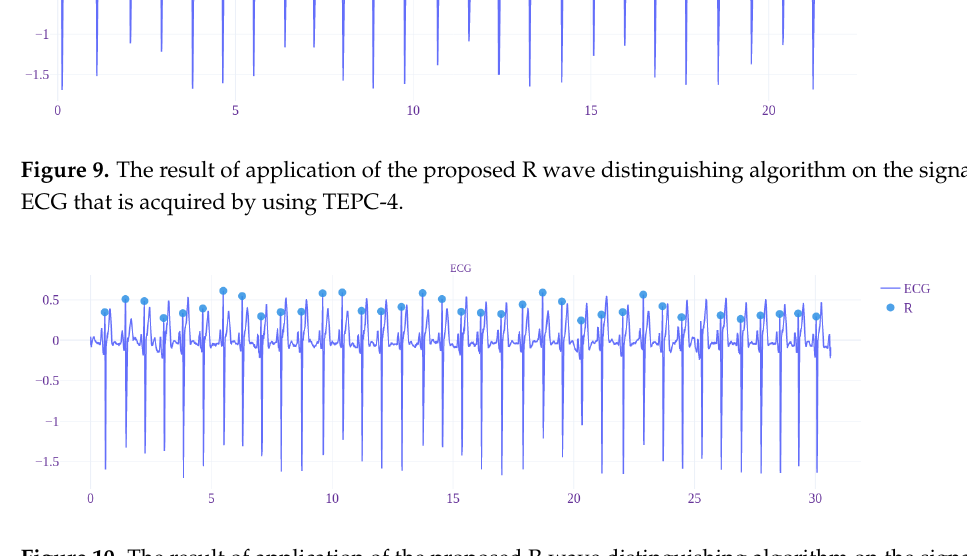
Figure 10. The result of application of the proposed R wave distinguishing algorithm on the signal of ECG that is acquired using